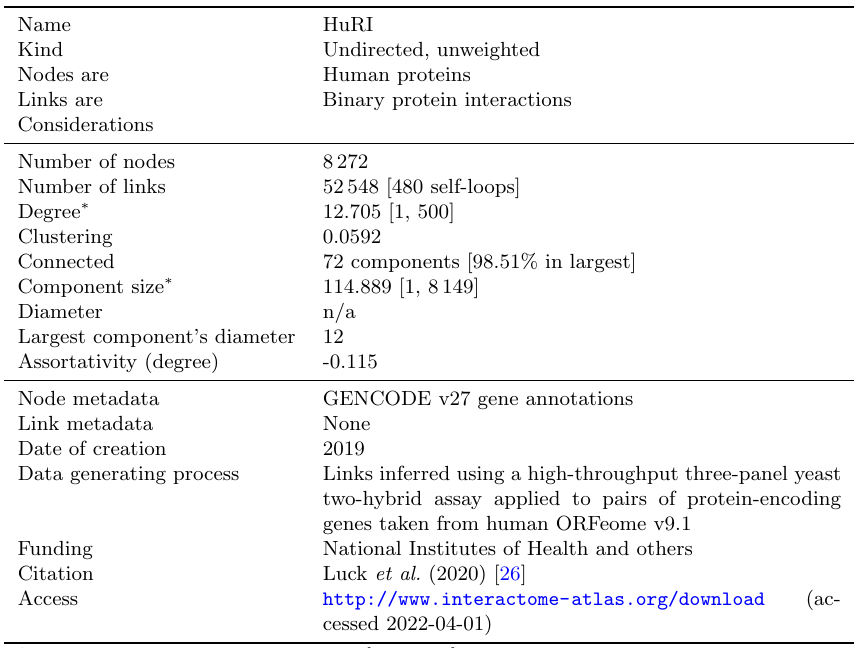
Table 5 Network card for a protein–protein interaction